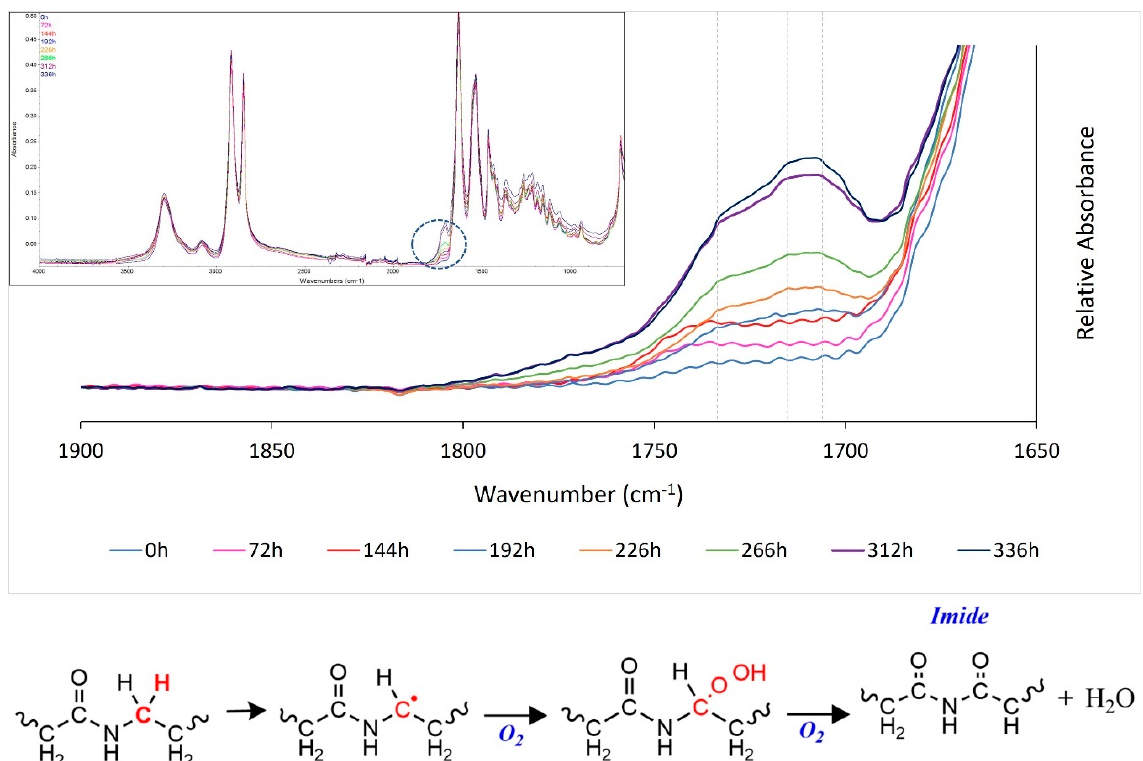
Figure 7. A full ATR-FTIR spectra for PA − 12, with the carbonyl region magnified to show the development of a new band at 1700–1760 cm − 1 , with absorption maxima appearing at 1705 cm − 1 , 1715 cm − 1 , and 1733 cm − 1 , as indicated by the dashed grey lines. The chemical reaction resulting in the formation of imide bonds is displayed.